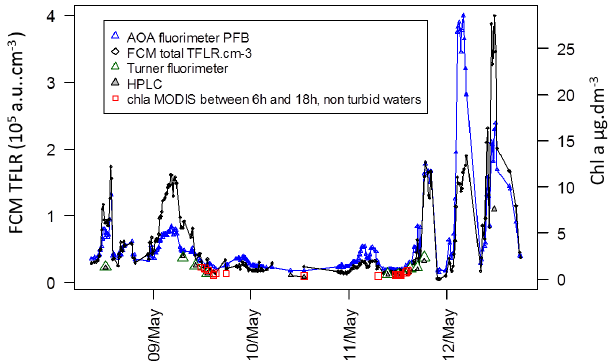
Figure 8. SFC total TFLR percm − 3 compared to Chl a analyses using different instruments. Refer to “Material and methods” for a detailed description of each method. Blue triangles: AOA fluorom- eter PFB (Chl a µgdm − 3 ) . Black diamonds: SFC total TFLRcm − 3 (a.u.cm − 3 ) . Green triangles: Turner fluorometer (Chl a µgdm − 3 ) . Grey triangles: HPLC (Chl a µgdm − 3 ) . Red squares: MODIS Chl a values corresponding to non-turbid waters (after Vantrepotte et al., 2012) and selected between 06:00 and 18:00 (Chl a µgdm − 3 )